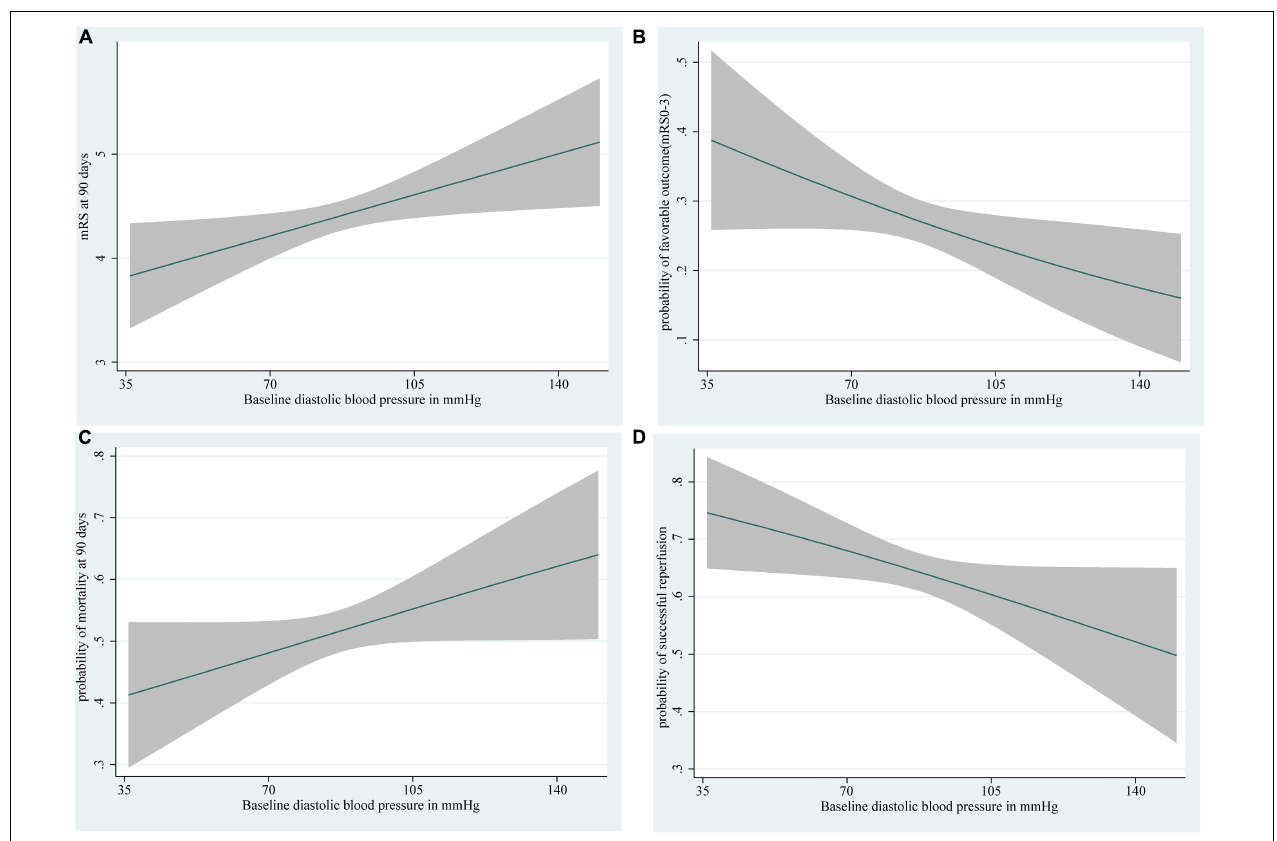
FIGURE 3 | Depiction of (A) the mRS score at 90 days, (B) the probability of a favorable outcome (mRS score 0–3), (C) the probability of 90-day mortality, and (D) the probability of successful reperfusion with 95% confidence intervals for each level of baseline DBP. The ranges of the x -axes correspond to the minimum and maximum systolic blood pressure values in this study (DBP: 36–150 mm Hg). Curves show the increases in (A) mRS score at 90 days, (C) an increased probability of 90-day mortality, (B) a decrease in predicted favorable outcome probabilities, and (D) a decreased probability of successful reperfusion with increases in DBP. DBP, diastolic blood